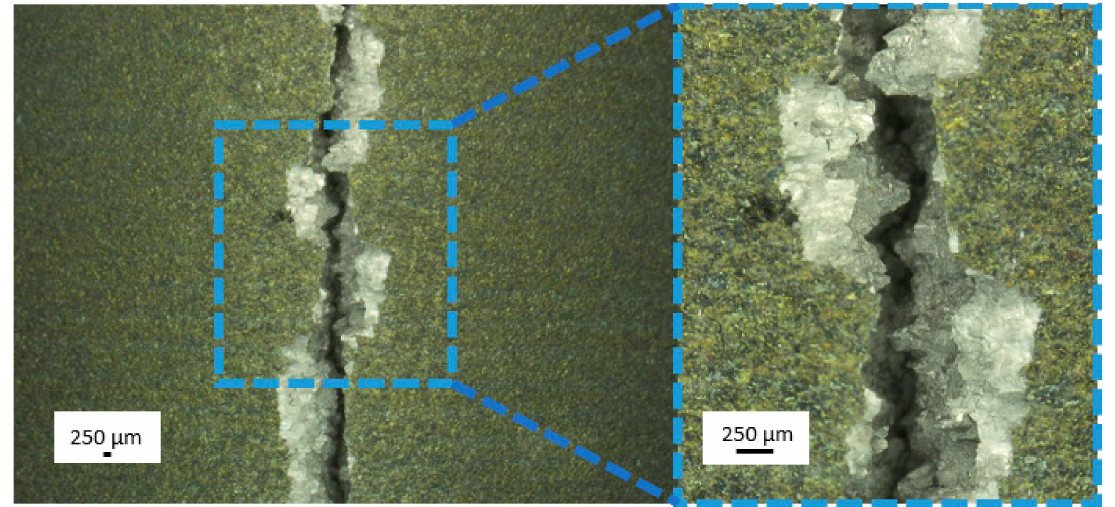
Figure 13. Light microscopy images of Ti-13Nb-13Zr samples after the three-point bending